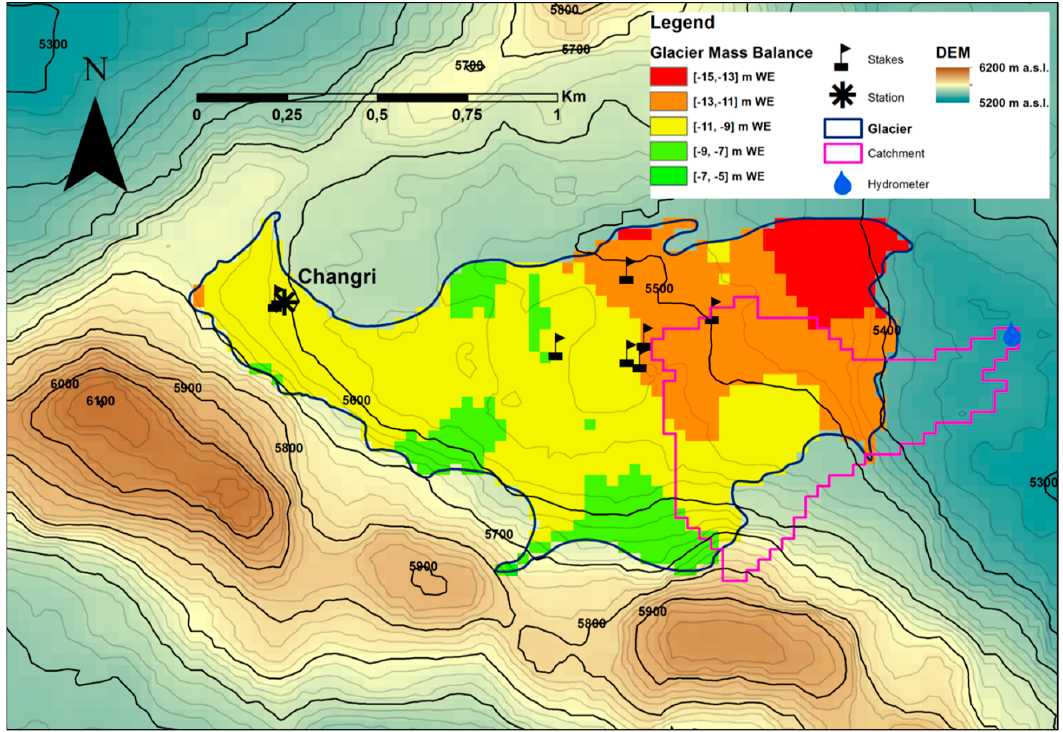
Figure 7. West Khangri Nup glacier. Spatially distributed mass balance (MB) (Equation (2)) in m of water equivalent (m WE), during 2010–2014 (30 June).